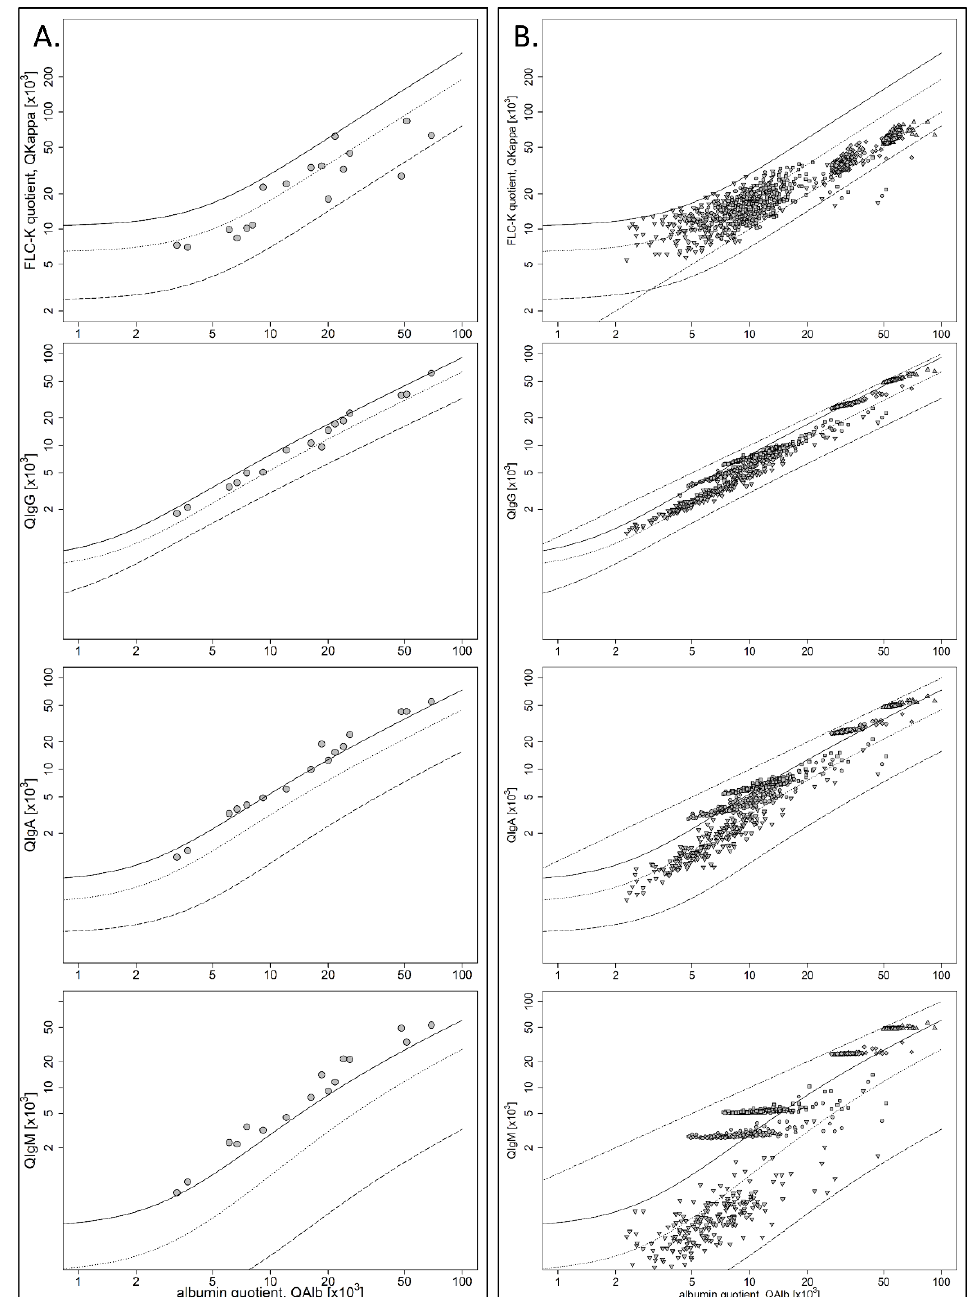
Figure 3. ( A ) Data of cohort II in double logarithmic IgG, IgA, IgM, and FLC-k quotient diagrams. All patients had a QFLC-k below the corresponding Qlim –FLC-k. ( B ) Data of the control group with a QFLC-k < Qlim –FLC-k ( ∇ ) and simulated blood contamination with 0.005 mL ( ○ ), 0.010 mL (□), 0.050 mL (◊), and 0.100 mL (∆) of serum in double-logarithmic IgG, IgA, IgM, and FLC-k quotient diagrams. QFLC-k = free light chain kappa quotient, Qlim –FLC-k = upper limit of the hyperbolic reference range.